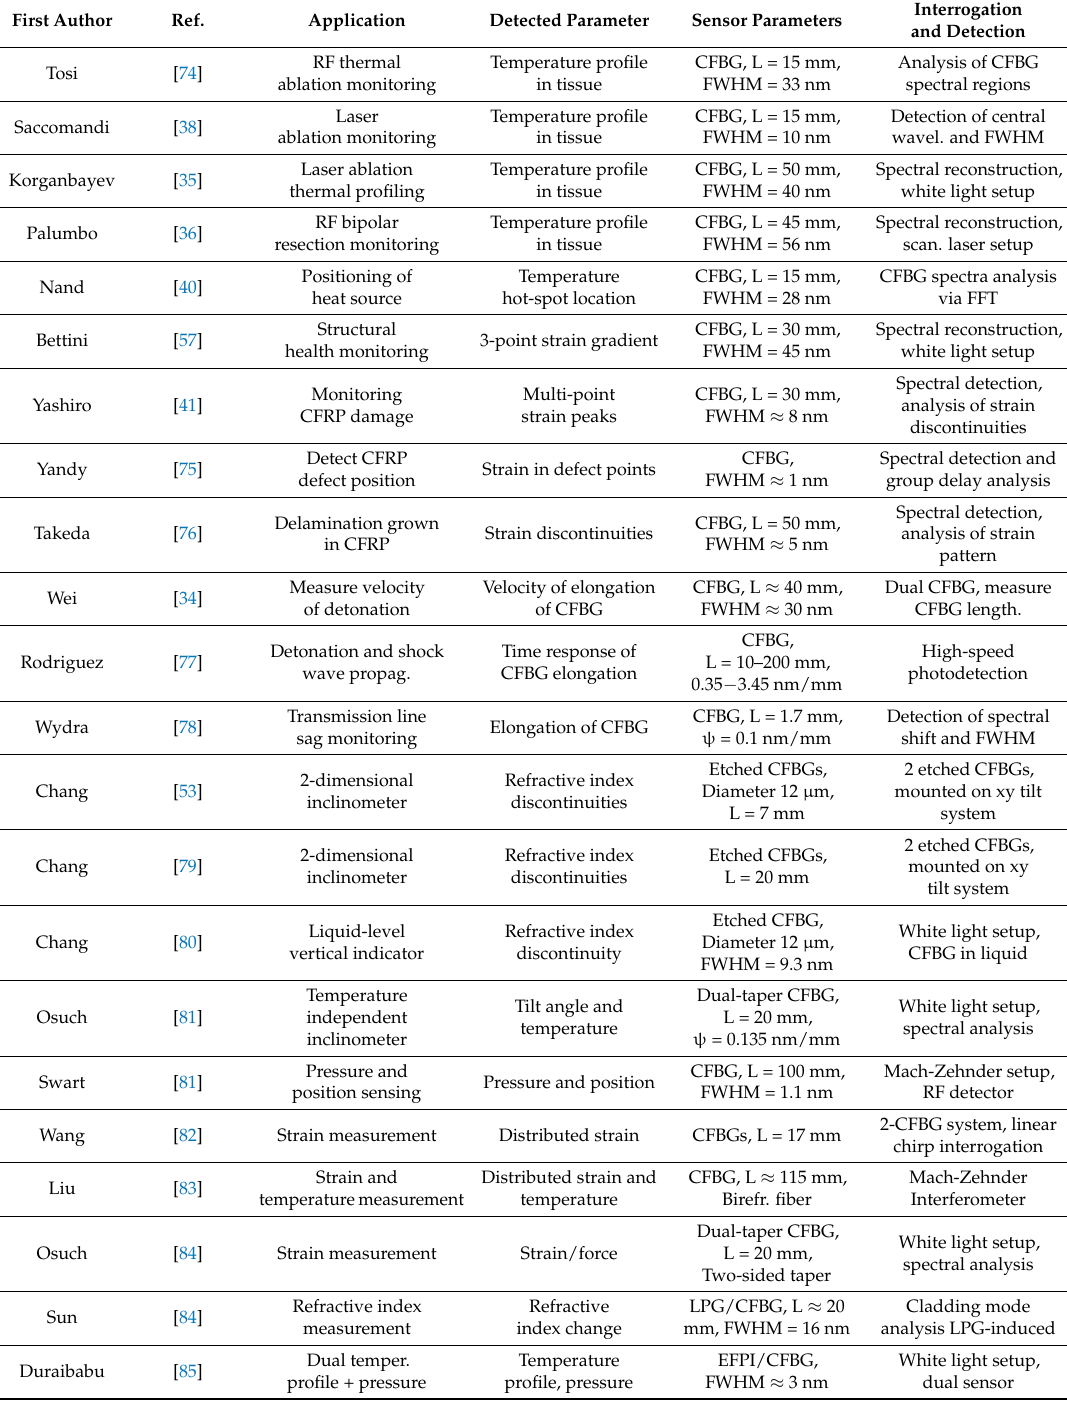
Table 2. Review of applications of CFBG